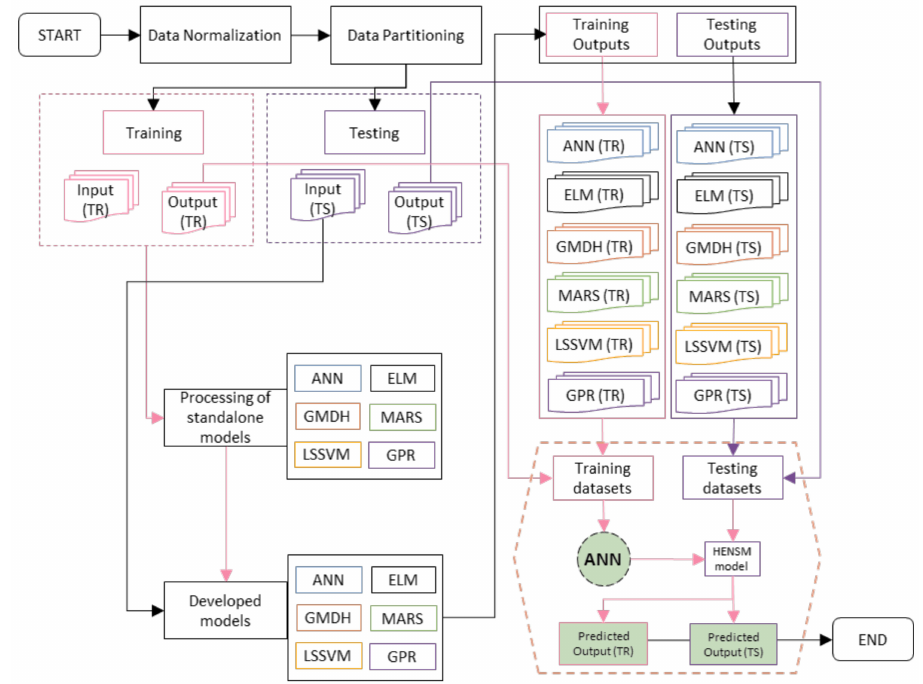
Figure 5. Flowchart of the implementation approach of the HENS